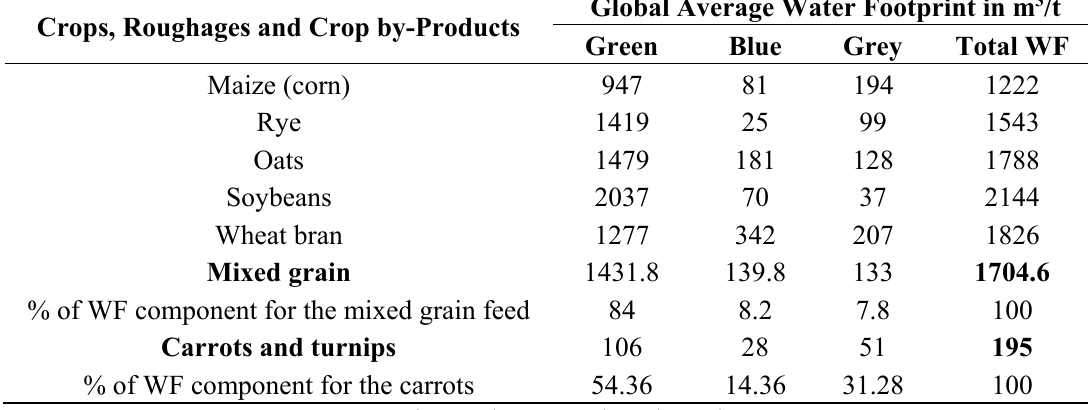
Table 2. Global average water footprints of the different crops, roughages, and crop by-products included in the mealworm farming system.